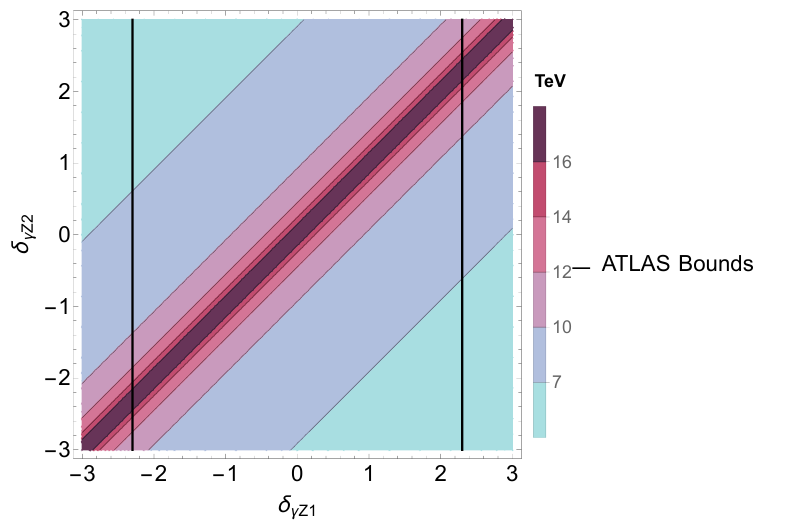
Figure 10 . The unitarity-violating scale that depends on both δ γZ 1 and δ γZ 2 . The solid black line represents the 95% C.L. limits on δ γZ 1 from ATLAS [27]. HL-LHC projections are